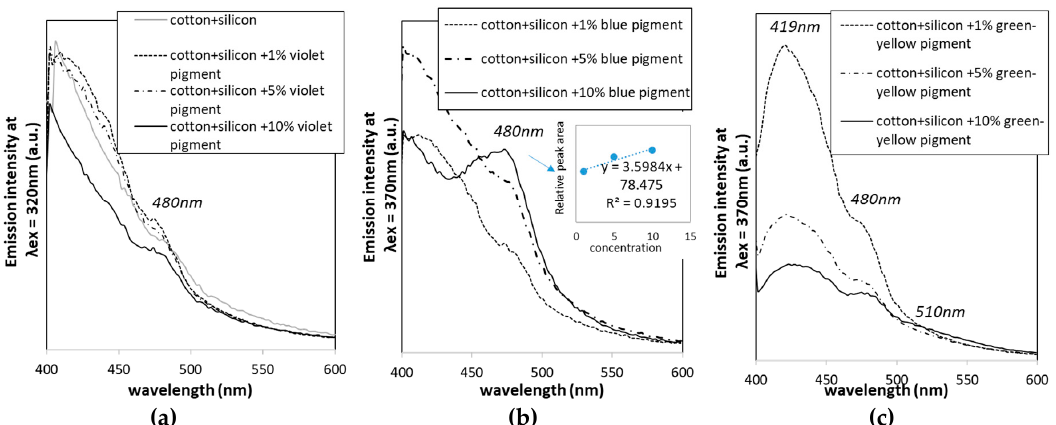
Figure 7. Emission spectra under pre-selected excitation wavelengths at 320 and 370 nm, obtained for the cotton printed with PDMS and different concentrations (1%, 5% and 10%) of blue ( a ), violet ( b ) and yellow-green luminescent pigments ( c ).